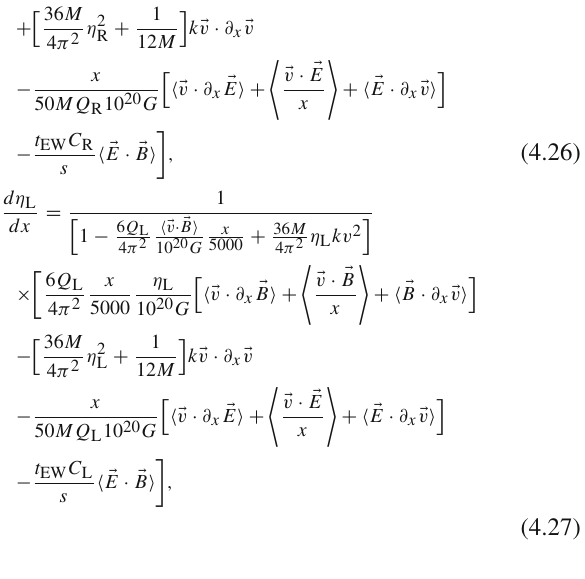
, b the left-handed electron asym- R